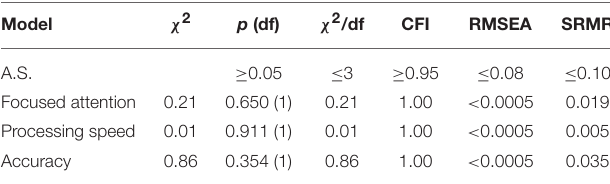
TABLE 3 | Goodness of fit statistics for the estimated models compared with recommendations for model evaluation by Schermelleh-Engel et al.